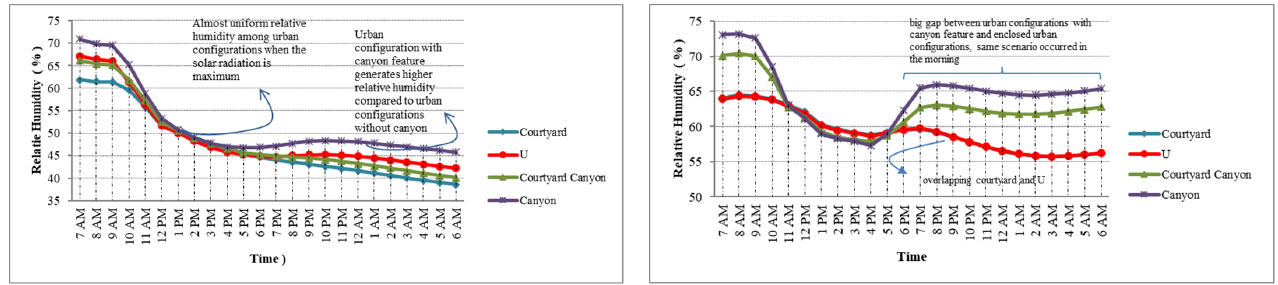
Figure 12. Air temperature vs. time at FBTS ( left ) and SM ( right ).